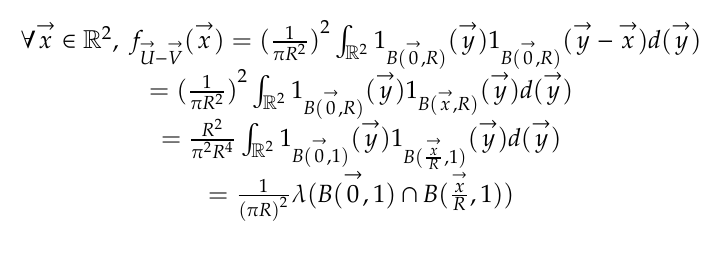
Figure 3. ( a ) The distribution of distance on a square. The graph for density is in red when polynomial (5). The light blue bars show a simulation from values generated by a homogeneous Poisson process in [ 0,1 ] × [ 0,1 ] with density ρ = 1500. ( b ) Densities in rectangles verifying allows the curves to share the same domain of definition). It appears that the more symmetrical the rectangle is, the rarer the longest and shortest distances